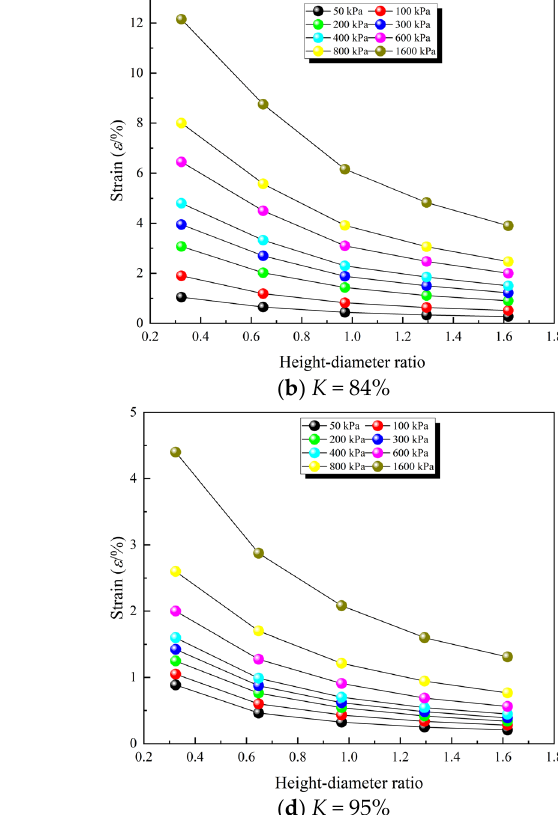
Figure 4. Preparation of cylindrical specimens for SEM tests.